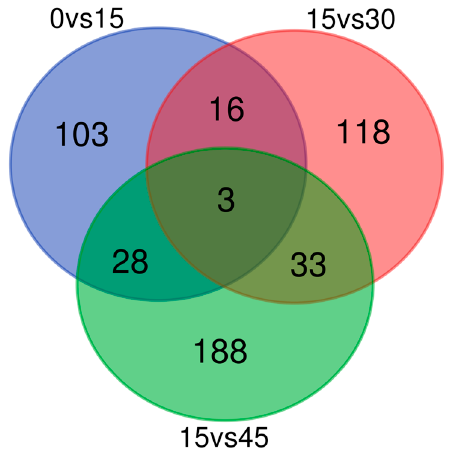
Figure 1. Global overview of differentially expressed unigenes based on Venn diagram.